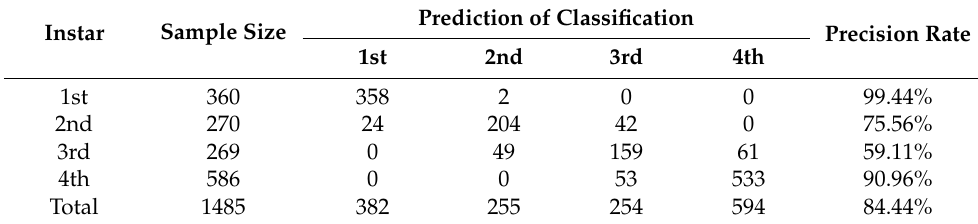
Table 6. Classification matrix for test larvae of Necrobia ruficollis